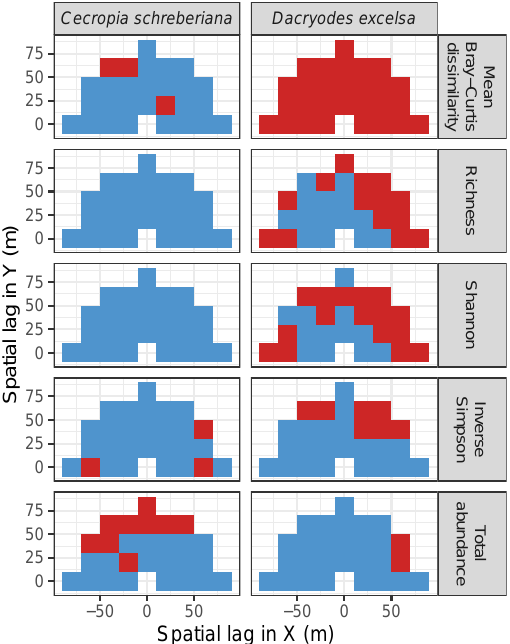
Figure A3. Statistical significance (red: P ≤ 0.05; blue: P > 0.05) of the codispersion coefficients calculated between measures of diversity and total basal area of the two focal tree species in 20 20-m × subplots in the 16-ha Luquillo plot (Figure 15). Statistical significance was determined by comparing observed codispersion at each spatial lag with a distribution of 199 spatial randomizations of a CSR null model.